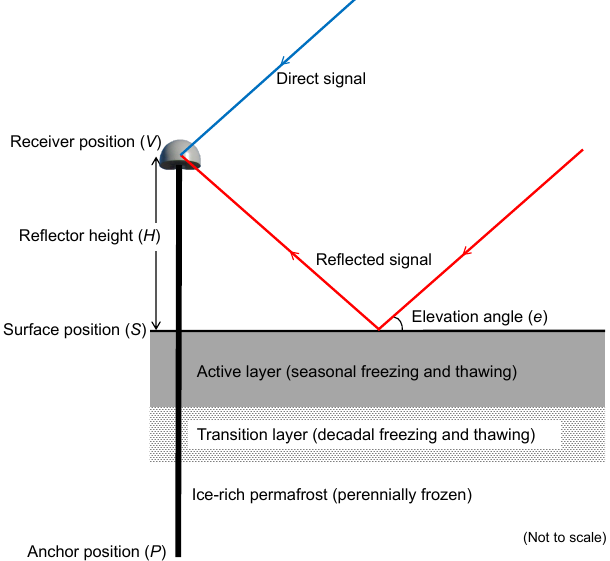
Figure 2. Schematic diagram of the GPS-IR geometry. The sub- surface in Barrow is depicted by a simplified three-layer model that consists of the active layer ( ∼ 53cm thick in August 2016), the tran- sition layer (thickness unknown), and the permafrost layer (>300m thick). The top of permafrost is